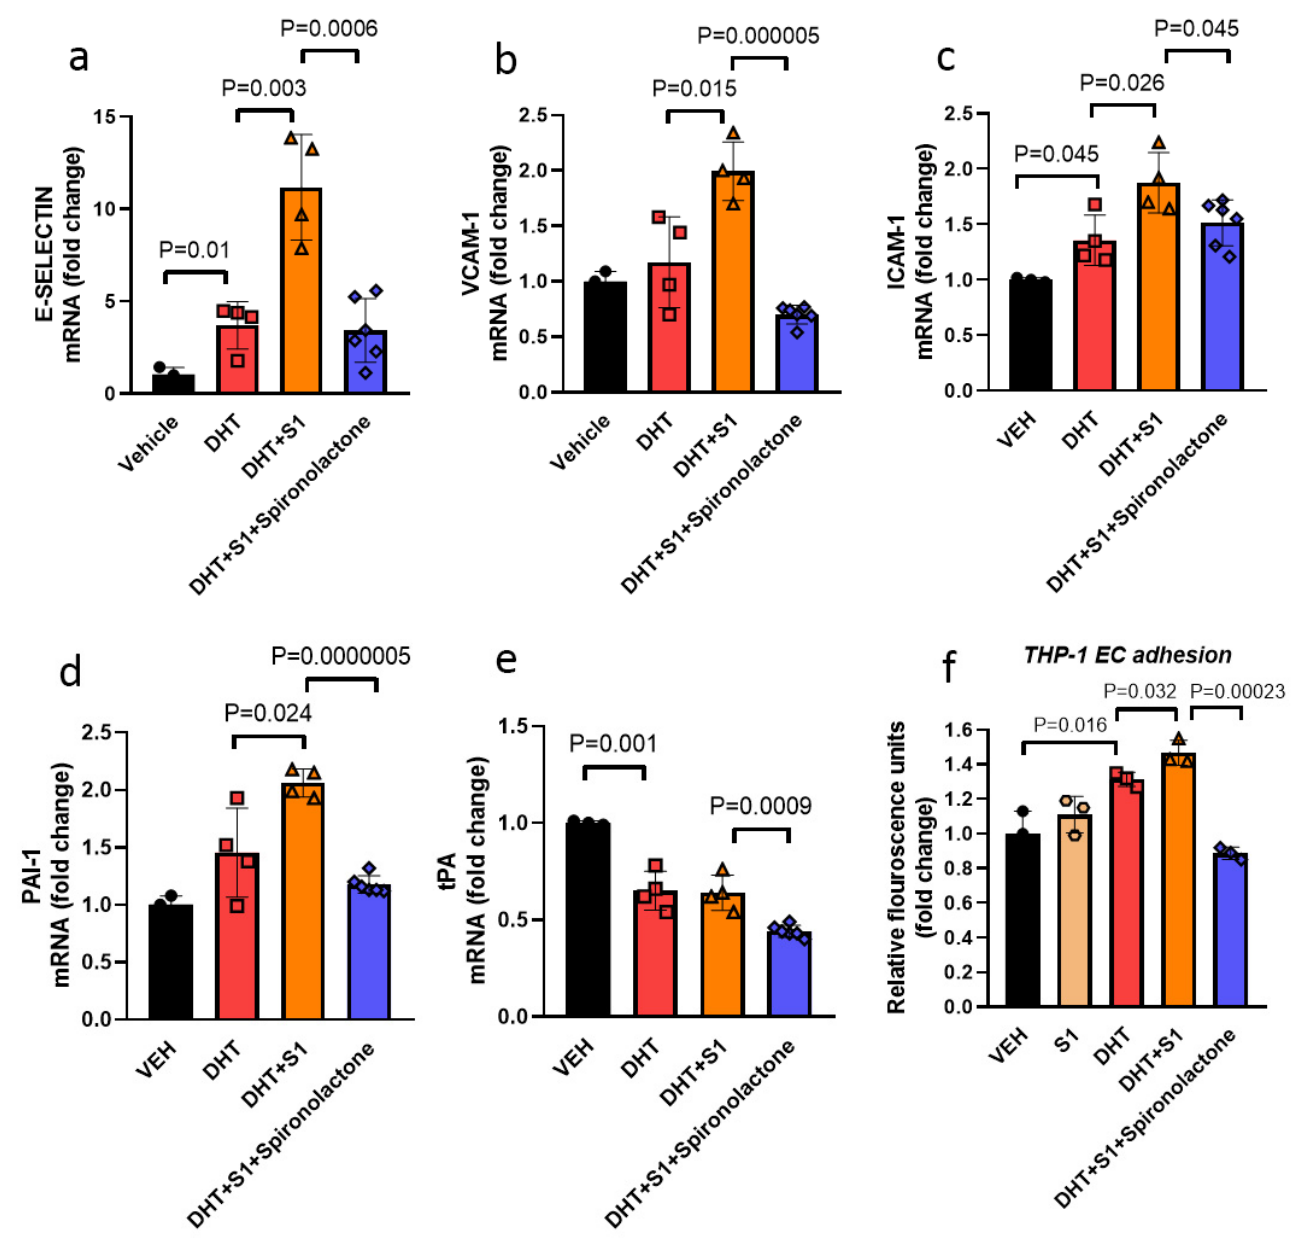
Figure 2. Co-treatment of ECs with SARS-CoV2 S1 with dihydrotestosterone (DHT) in vitro enhanced gene expression of cell adhesion molecules and anti-fibrinolytic marker and promoted leukocyte adhesion, with beneficial effects of spironolactone treatment. ( a ) Transcript expression of cell adhesion molecule E-selectin was increased by DHT alone (500 nM) as compared to the vehicle and expression of E-selectin was enhanced by S1 (25 nM) in the presence of DHT (n = 4). ( b , c ) VCAM-1 and ICAM-1 transcript expression were also enhanced by S1 in the presence of DHT as compared to DHT alone. ( d ) Co-treatment of S1 with DHT enhanced PAI-1 transcript expression. ( e ) Transcript expression of fibrinolytic tPA was significantly downregulated by DHT alone, while co-treatment with S1 did not further change tPA transcript expression. ( f ) DHT treatment increased the adhesion of human THP-1 monocytes to EC monolayers, which was further enhanced by the S1 exposure. Spironolactone (10 mM) reduced the transcript expression of cell adhesion molecules (E-selectin, VCAM-1 and ICAM-1) and anti-fibrinolytic/fibrinolytic PAI-1/tPA, respectively, and blocked the adhesion of THP-1 to ECs monolayer in vitro (n = 3–4). • (Vehicle), (cid:4) (DHT), (cid:78) (DHT+S1), (cid:7) (DHT+S1+Spironolactone), (S1). Data were analyzed by the analysis of variance (ANOVA). p < 0.05 was defined to be statistically significant. All data are expressed as mean ± s.d.